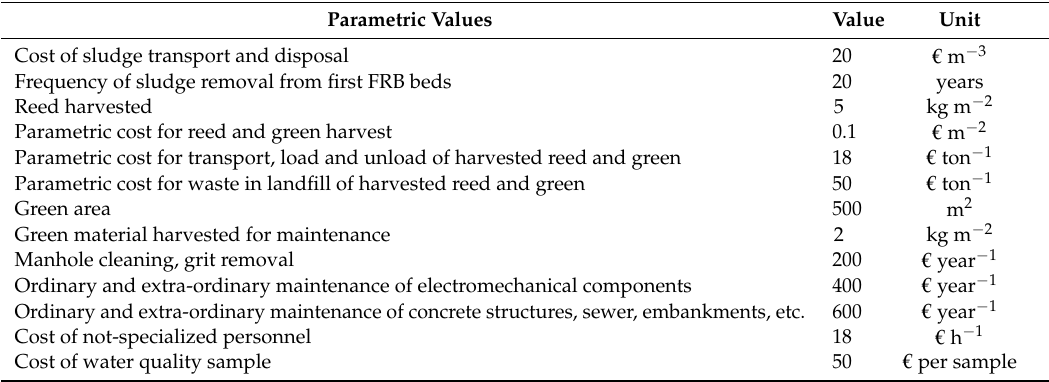
Utility did not provide